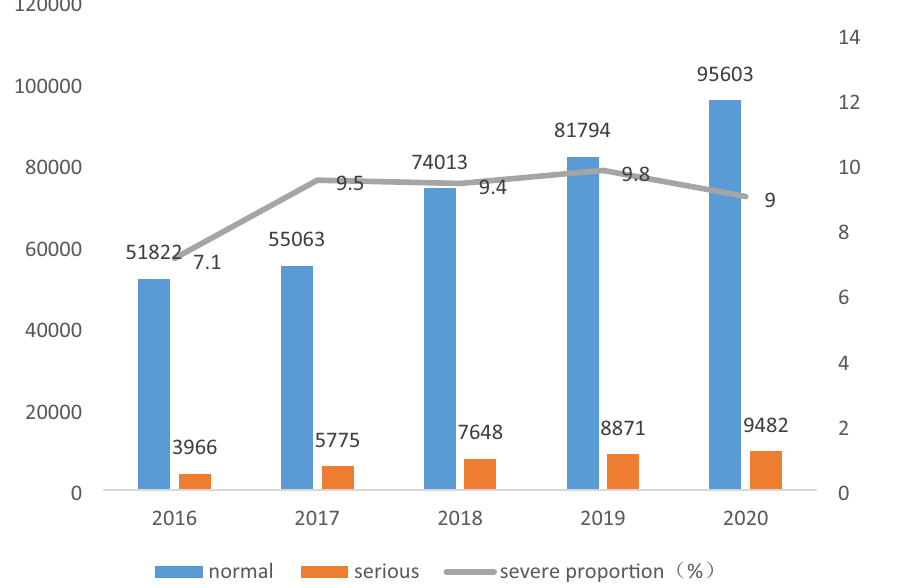
Figure 3. Number of ADR cases from 2016 to 2020.